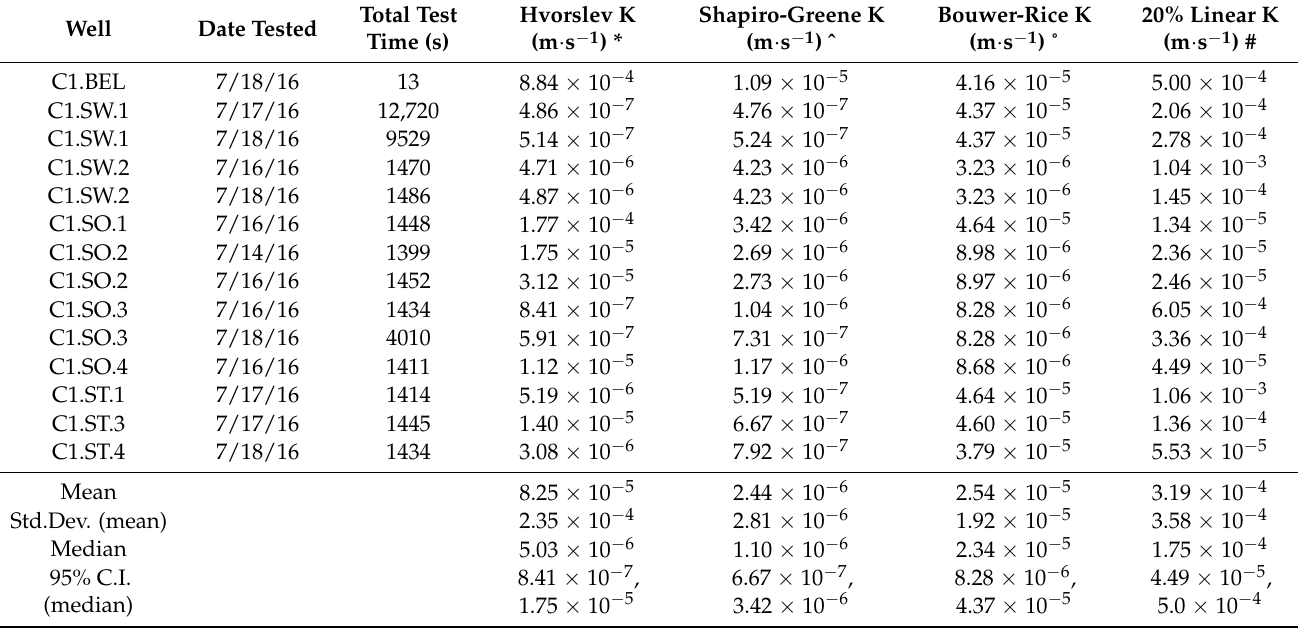
Table 1. Summary of saturated hydraulic conductivity (K) values calculated by several methods from falling head slug tests at the C1 well field, Niwot Ridge,